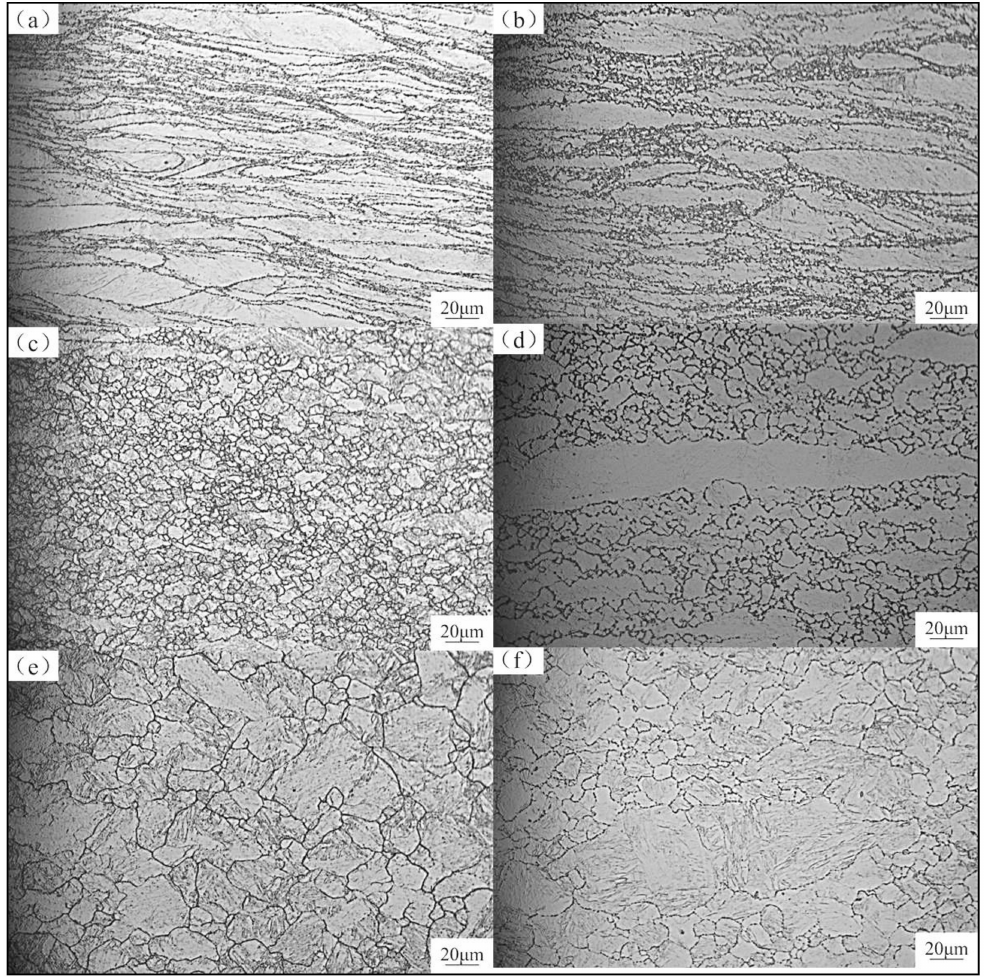
Figure 11. Optical micrographs of the fine- and coarse-grained specimens at di ff erent deformation conditions: ( a , c , e )fine-grainedsamples; ( b , d , f )coarse-grainedsamples; ( a , b )highZ;( c , d )intermediateZ; ( e , f ) low